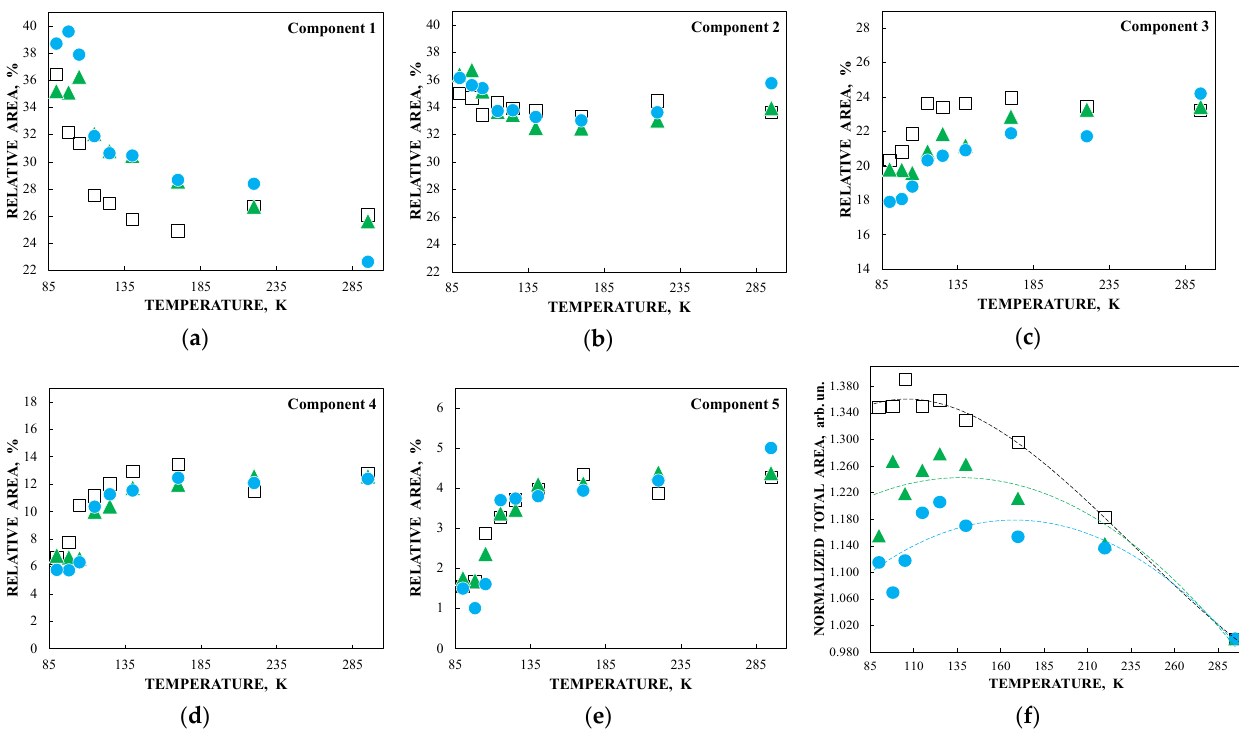
Figure 27. Unusual temperature dependencies of quadrupole splitting for spectral components 1 ( a ), 2 ( b ), 3 ( c ), 4 ( d ) and 5 ( e ) obtained within the new heterogeneous iron core model used for fit ‐ ting the Mössbauer spectra of Ferrum Lek (  ), Maltofer® (  ) and Ferrifol (  ). Data were taken from Refs. [49–51].